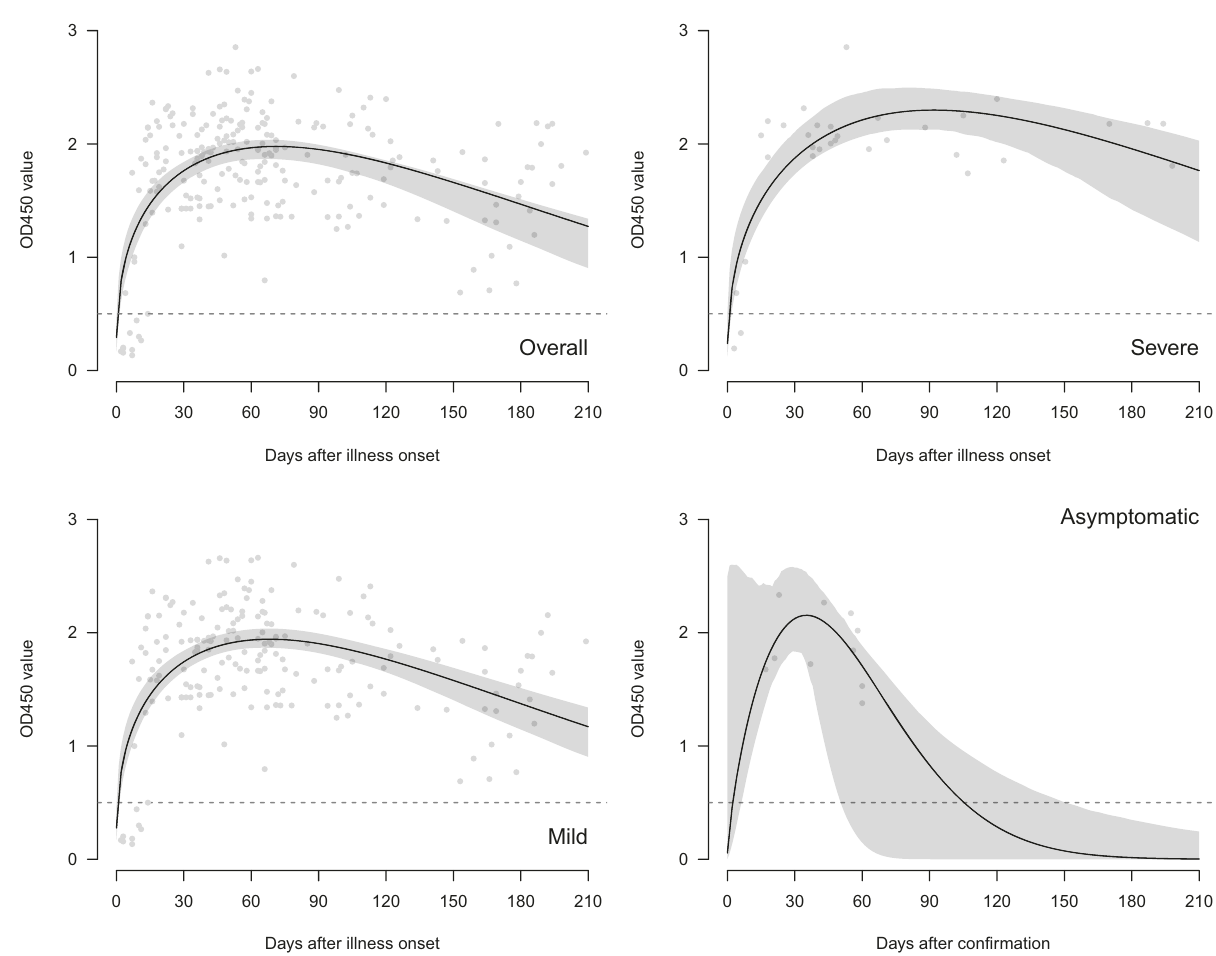
Fig. 4 Antibody responses (ELISA) in COVID-19 patients by days after illness onset and severity, Hong Kong ( n = 231 samples). The black lines showed the fi tted values and gray areas showed the 95% con fi dence intervals. ELISA assays were carried out in